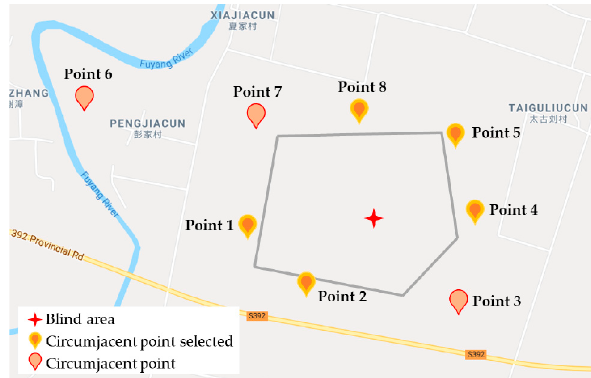
Figure 5. Layout of the monitoring grid and the points in the selected industrial park.